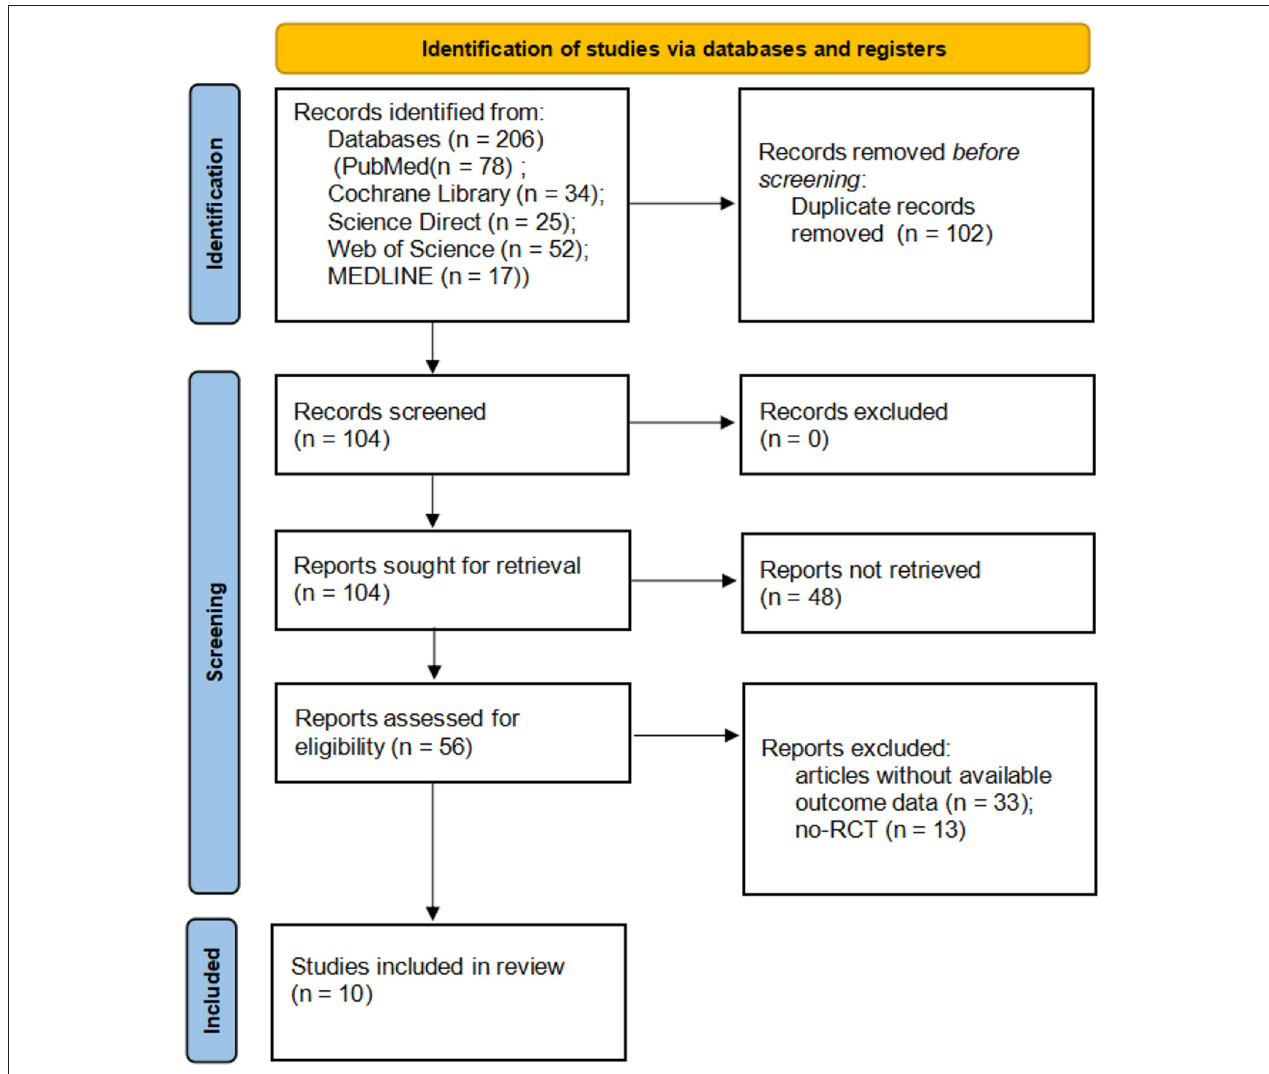
FIGURE 1 | PRISMA flowchart of the study selection process. randomized controlled